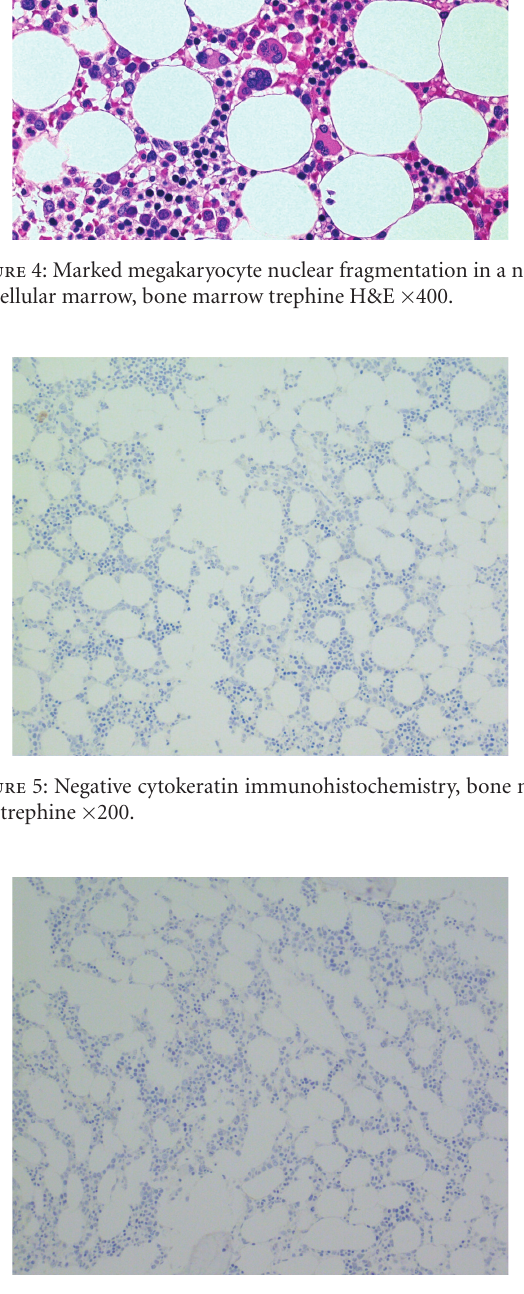
Figure 6: Negative synaptophysin immunohistochemistry, bone marrow trephine ×